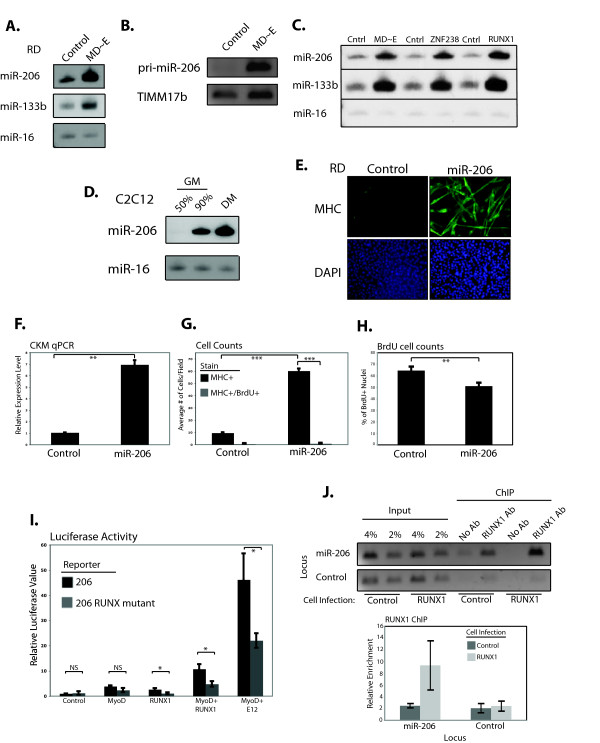
MyoD ~ E, RUNX1, and ZNF238 increase miR-206. (A) microRNA northern blots to detect the mature form of the indicated microRNAs in RD cells infected with either empty (control) retrovirus, or retrovirus expressing MyoD ~ E (MD ~ E). (B) RT-PCR using primers located in the pre- and pri-miR-206 sequence to detect the primary miR-206 transcript. TIMM17b is the internal control. (C) microRNA northerns as in 2A, in RD cells expressing a transcription factor as indicated. (D) microRNA northerns in C2C12 cells at various stages of differentiation ranging from undifferentiated myoblasts (50% GM), through beginning differentiation (90% GM) to myotubes (DM). (E) Immunostains for MHC in RD cells transiently transfected with either a pre-miR-206 RNA construct, or a negative control construct. Nuclei were stained with DAPI. (F) qPCR for CKM in RD cells treated as in E. (G) RD cells treated as in E were pulsed with BrdU for 24 h and then stained and counted to determine the extent of co-localization of MHC + myotubes and BrdU + nuclei. (H) RD cells transiently transfected as in E were pulsed for 24 h with BrdU-containing differentiation media before fixation and quantification of the percentage of BrdU positive cells. The percent reduction of BrdU + nuclei almost exactly equals the percent of cells found to be MHC + (not shown). (I) Luciferase activity in RD cells using a miR-206 promoter driven reporter and transiently transfected factors as indicated. ‘206 RUNX mutant’ indicates that the reporter has had a putative RUNX1 binding site mutated to prevent RUNX1 binding. Control indicates transfection with an empty plasmid. All luciferase assays were normalized to the results from a co-transfected renilla plasmid. (J) RUNX1 ChIP assays, both with normal PCR and qPCR results, at the miR-206 promoter and a control locus before (Control) and after (RUNX1) infection of the cells with empty or RUNX1-expressing retrovirus. All PCRs in the imaged gel (upper) were performed for the same number of cycles. qPCR results (lower) represent the mean ± SEM of two independent ChIP experiments. Relative enrichment is calculated as the ratio of the % of input amplified with antibody to the % of input amplified with no antibody. All other graphs in this figure represent the mean ± SEM of at least three independent experiments. * : P < 0.05; ** : P < 0.01; *** : P < 0.001.